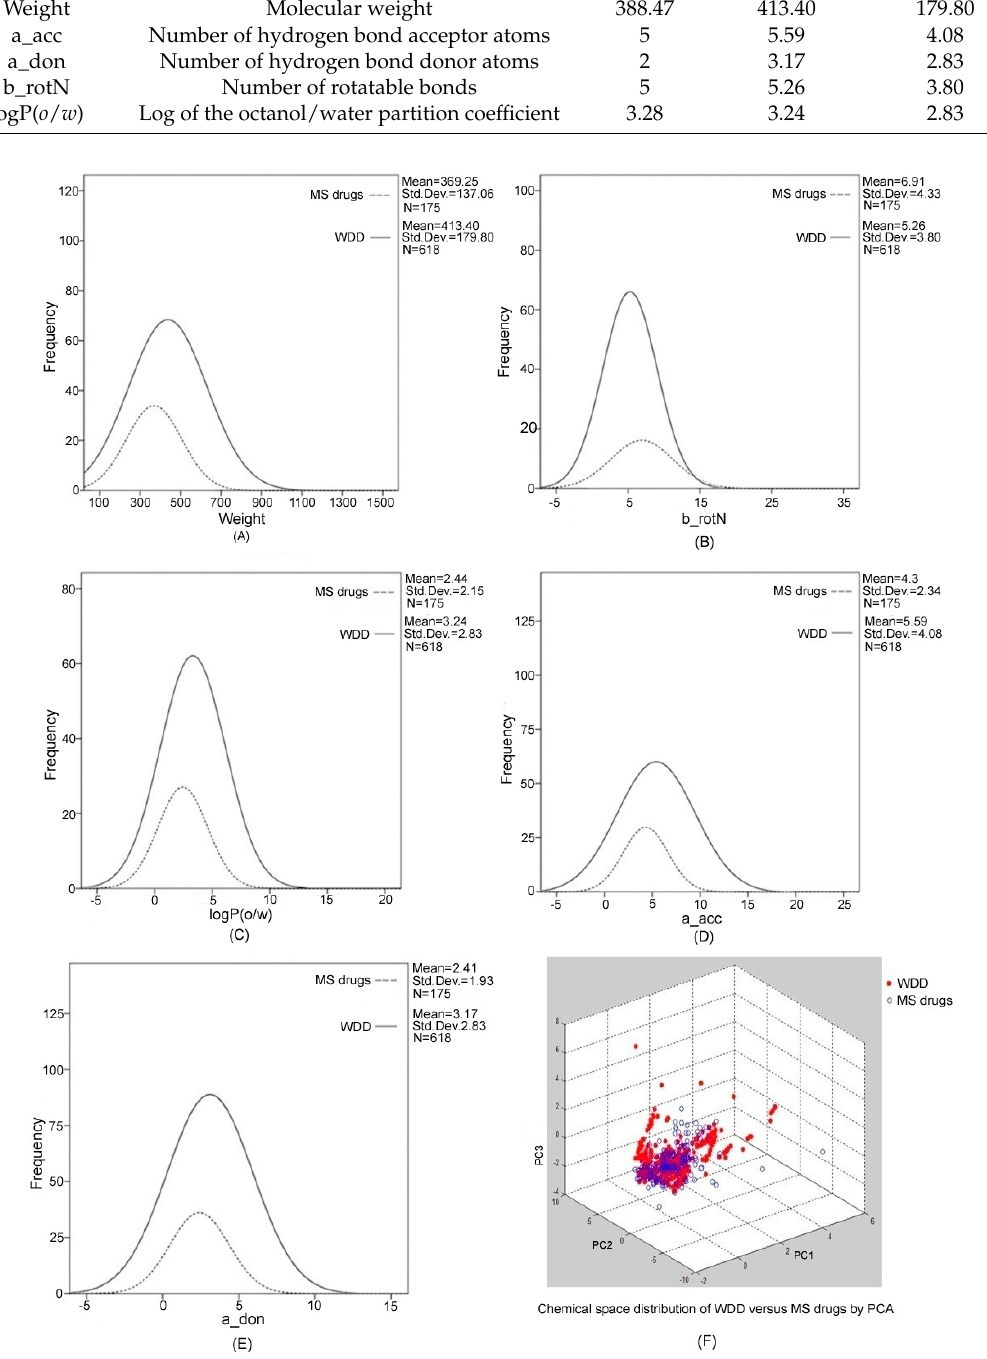
Figure 1. Comparing chemical characteristics of ingredients in WDD versus metabolic syndrome (MS) drugs. ( A – E ) are distributions of drug-like properties of ingredients in WDD and MS drugs; ( F ) chemical space distribution of WDD versus MS drugs by principal component analysis (PCA).